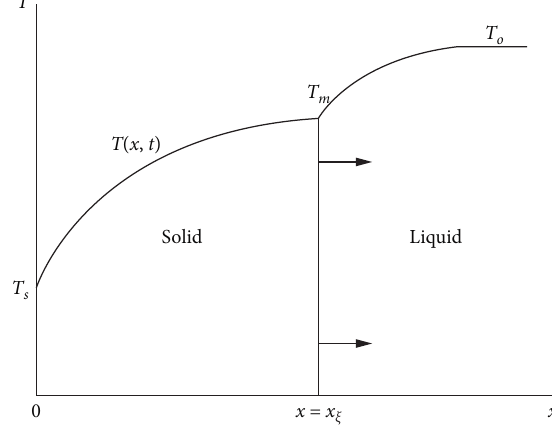
Figure 4: Coordinate for two-phase